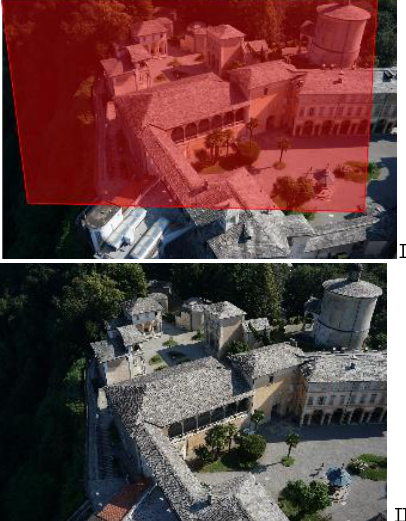
Figure 6. Example of consecutive oblique images with underlined an approximated overlapping area (in red in I).